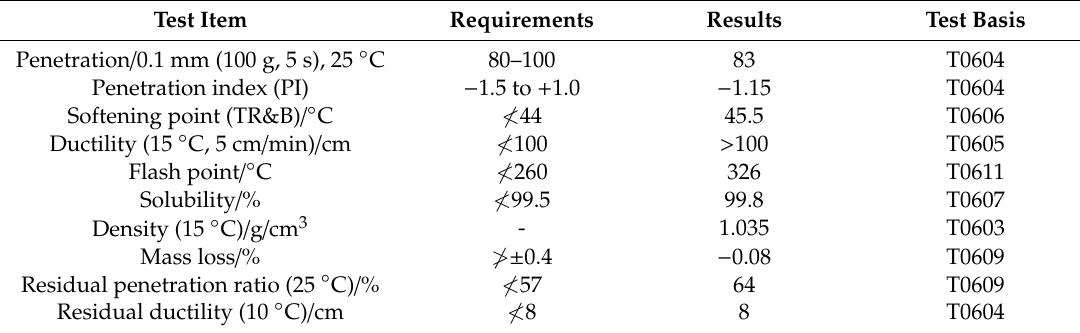
Table 2. Physical properties of SK-90# asphalt.